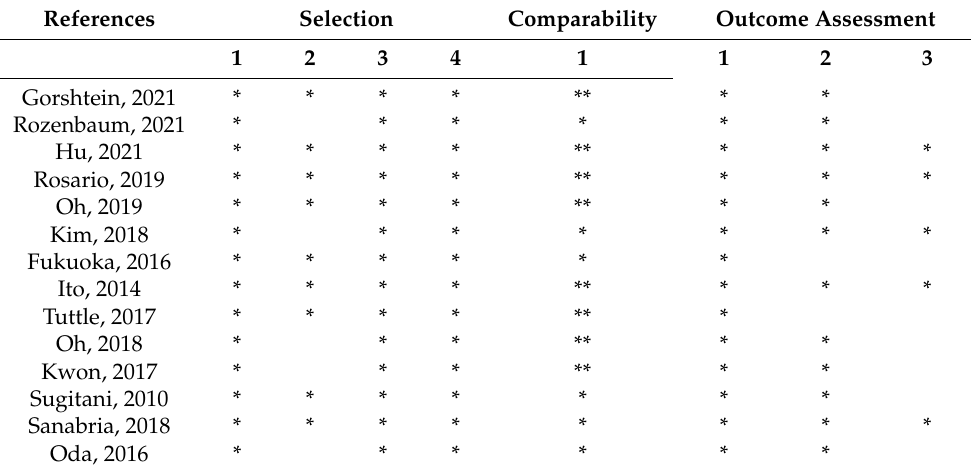
Table 1. Newcastle-Ottawa Scale (NOS).